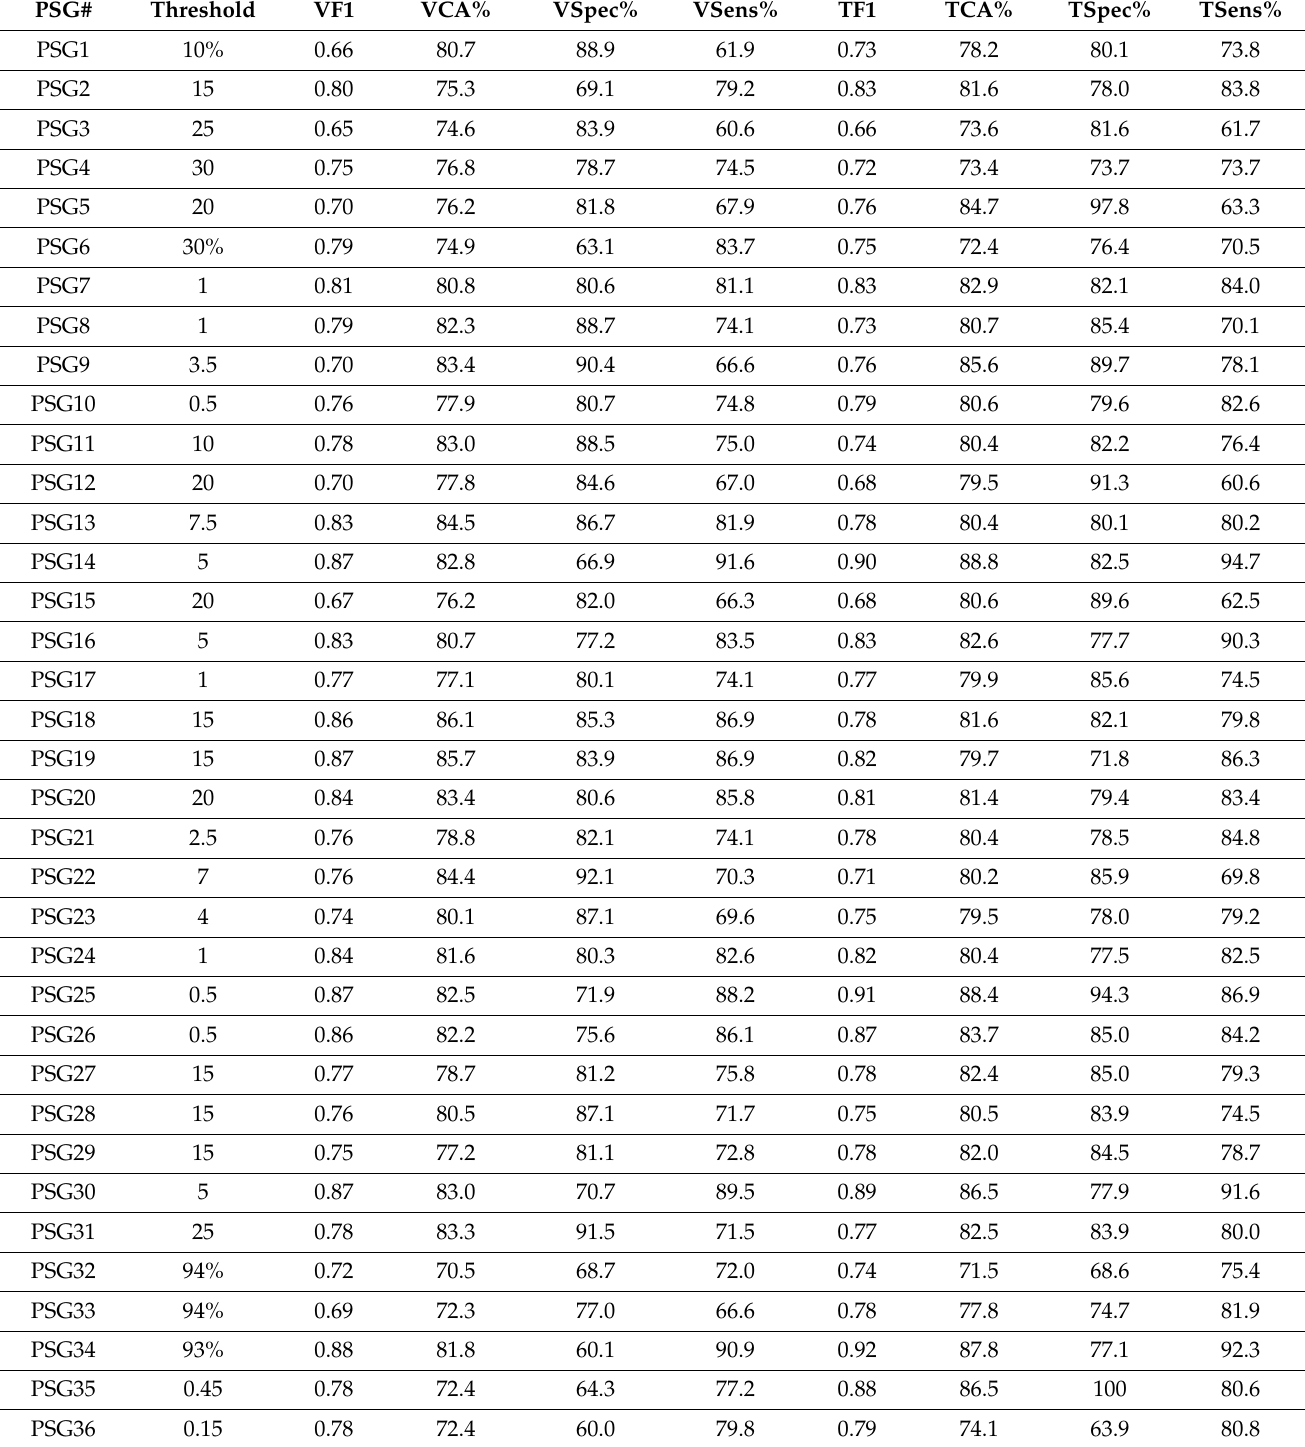
Table 5. The average validation and testing accuracies for classifying data around the selected threshold using the outcomes of the bilinear